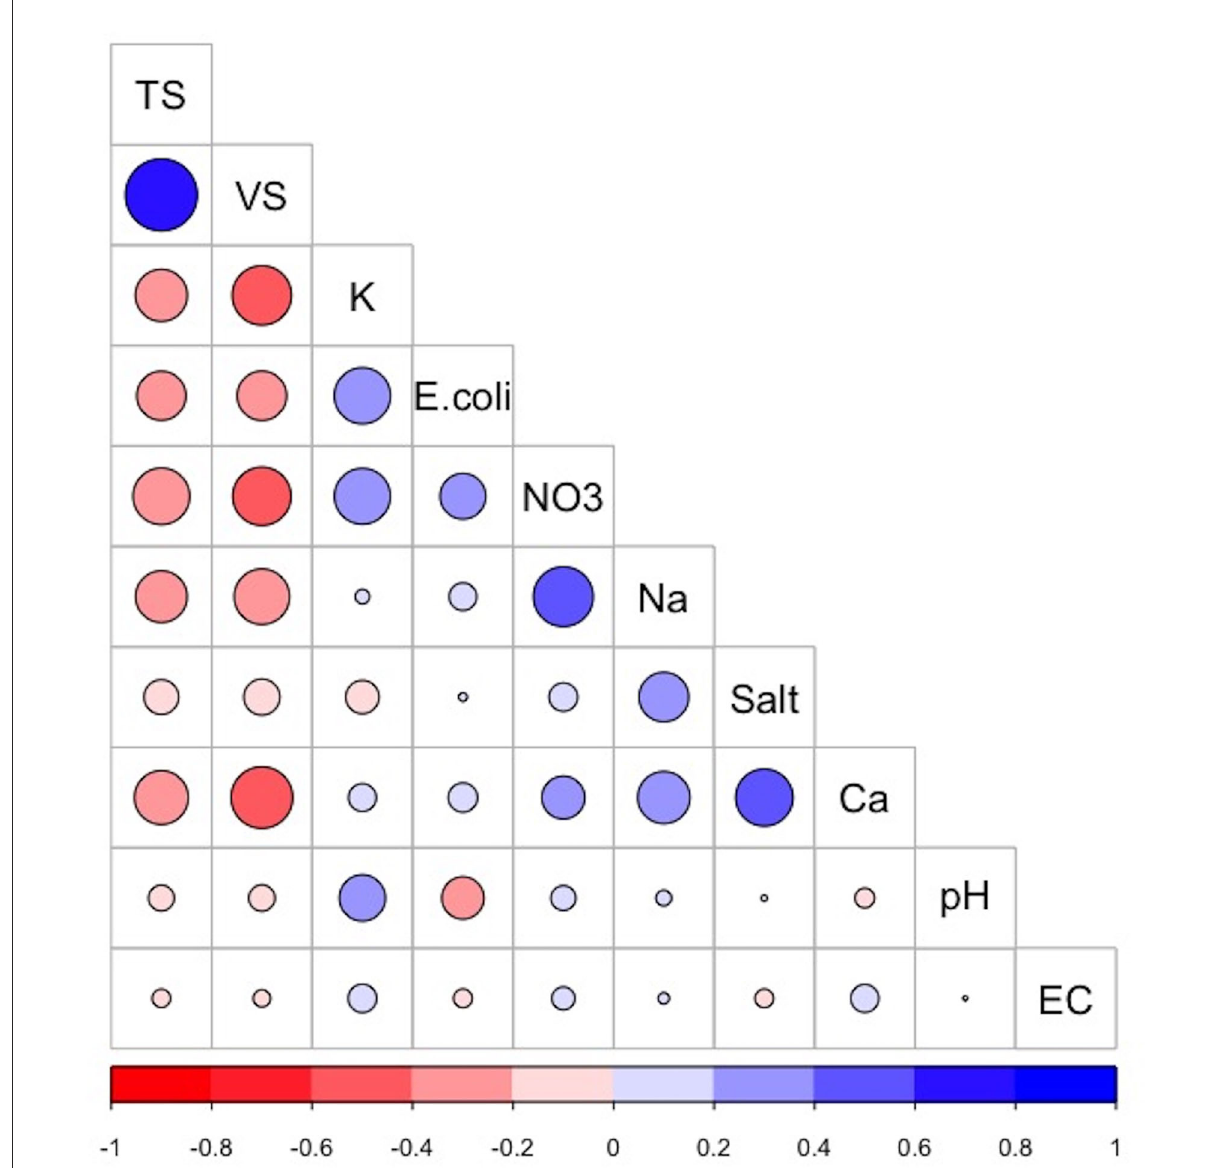
FIGURE2 Correlogram showing the correlation matrix between the various dairy effluent parameters. The positive correlations and negative correlations are colored blue and red , respectively. The intensity and size of the circle are proportional to the correlation coefficients. Abbreviations used: TS, Total Solids; VS, Volatile Solids; K, Potassium; NO3, nitrates; Na, Sodium; Ca, Calcium; Salt, Total Salts; EC, Electrical Conductivity. The image was generated using the “Corrplot” package in R version 4.0.3.